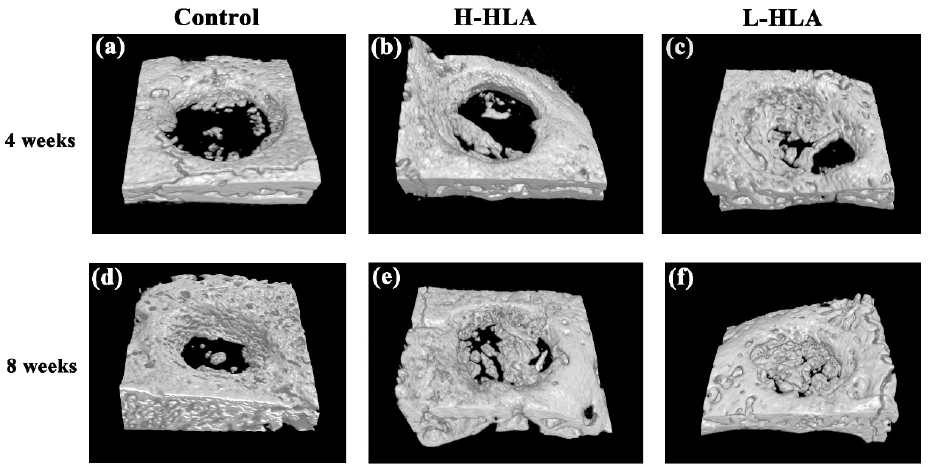
Figure 6. Micro-CT 3D images of tested bone defects grafted with HLA-free HA/ β -TCP bone graft ( a , d ), bone graft mixed with H-HLA ( b , e ), and L-HLA-HA/ β -TCP ( c , f ) at 4 weeks ( a – c ) and 8 weeks ( d – f ) post healing.